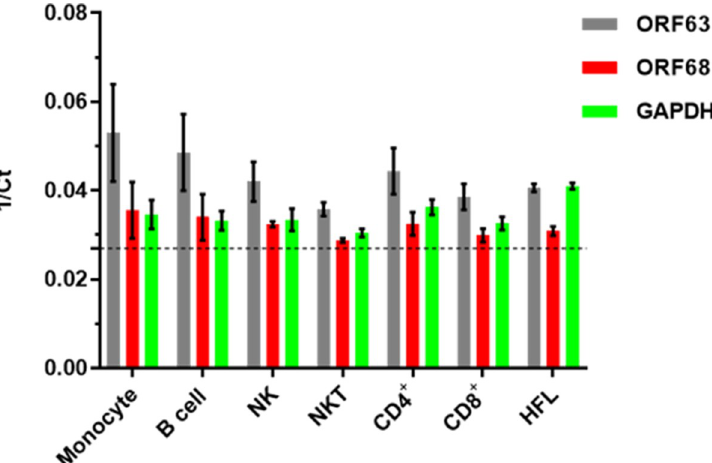
Fig 3. Quantitative RT-PCR analyses of GAPdH, VZV ORF63 and ORF68 expression in VZV-infected monocytes, NK cells, NKT cells, B cells, CD4 + T cells, CD8 + T cells and HFLs. Human PBMCs were infected with VZV as described in Fig 1, then uninfected- and VZV-infected monocytes, NK cells, NKT cells, B cells, CD4 + T cells and CD8 + T cells were sorted using flow cytometry. RNA was harvested and then analyzed by quantitative RT-PCR for ORF63 (grey bars), ORF68 (red bars) and GAPdH (green bars) transcripts. In addition, VZV-infected HFLs that were > 90% VZV gE+ based upon flow cytometry analyses were harvested as a positive control for viral transcript expression. Results representative of sorted PBMCs from 3 different healthy individuals and from 3 independent HFL infections, with bar graphs representing average 1/Ct ± SD. Dotted line represents threshold for Ct values (1/36). All immune cell populations were > 93% pure based upon flow cytometry